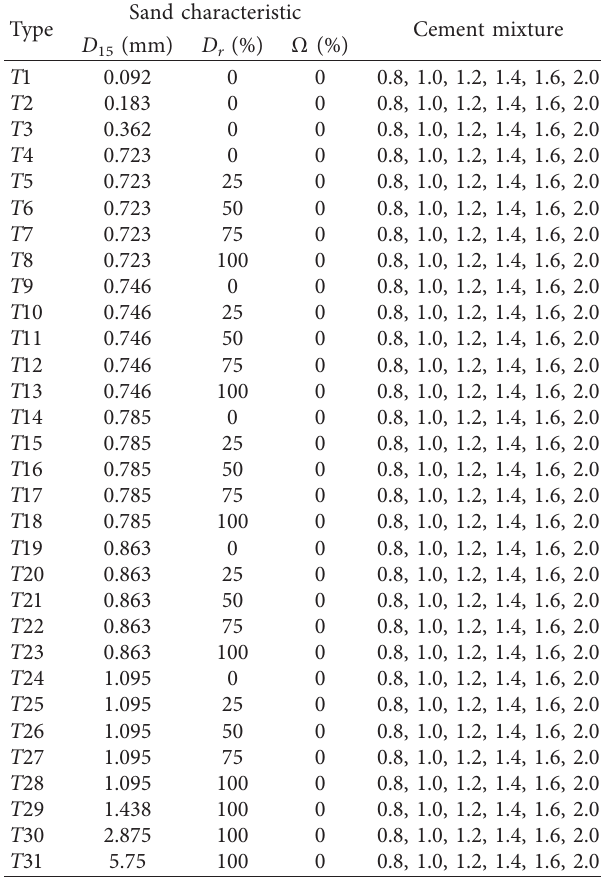
Table 5: The test plan for sand layer groutability with clay content being